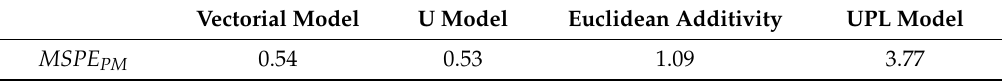
Table 9. Mean squared prediction error values determined for perceptual